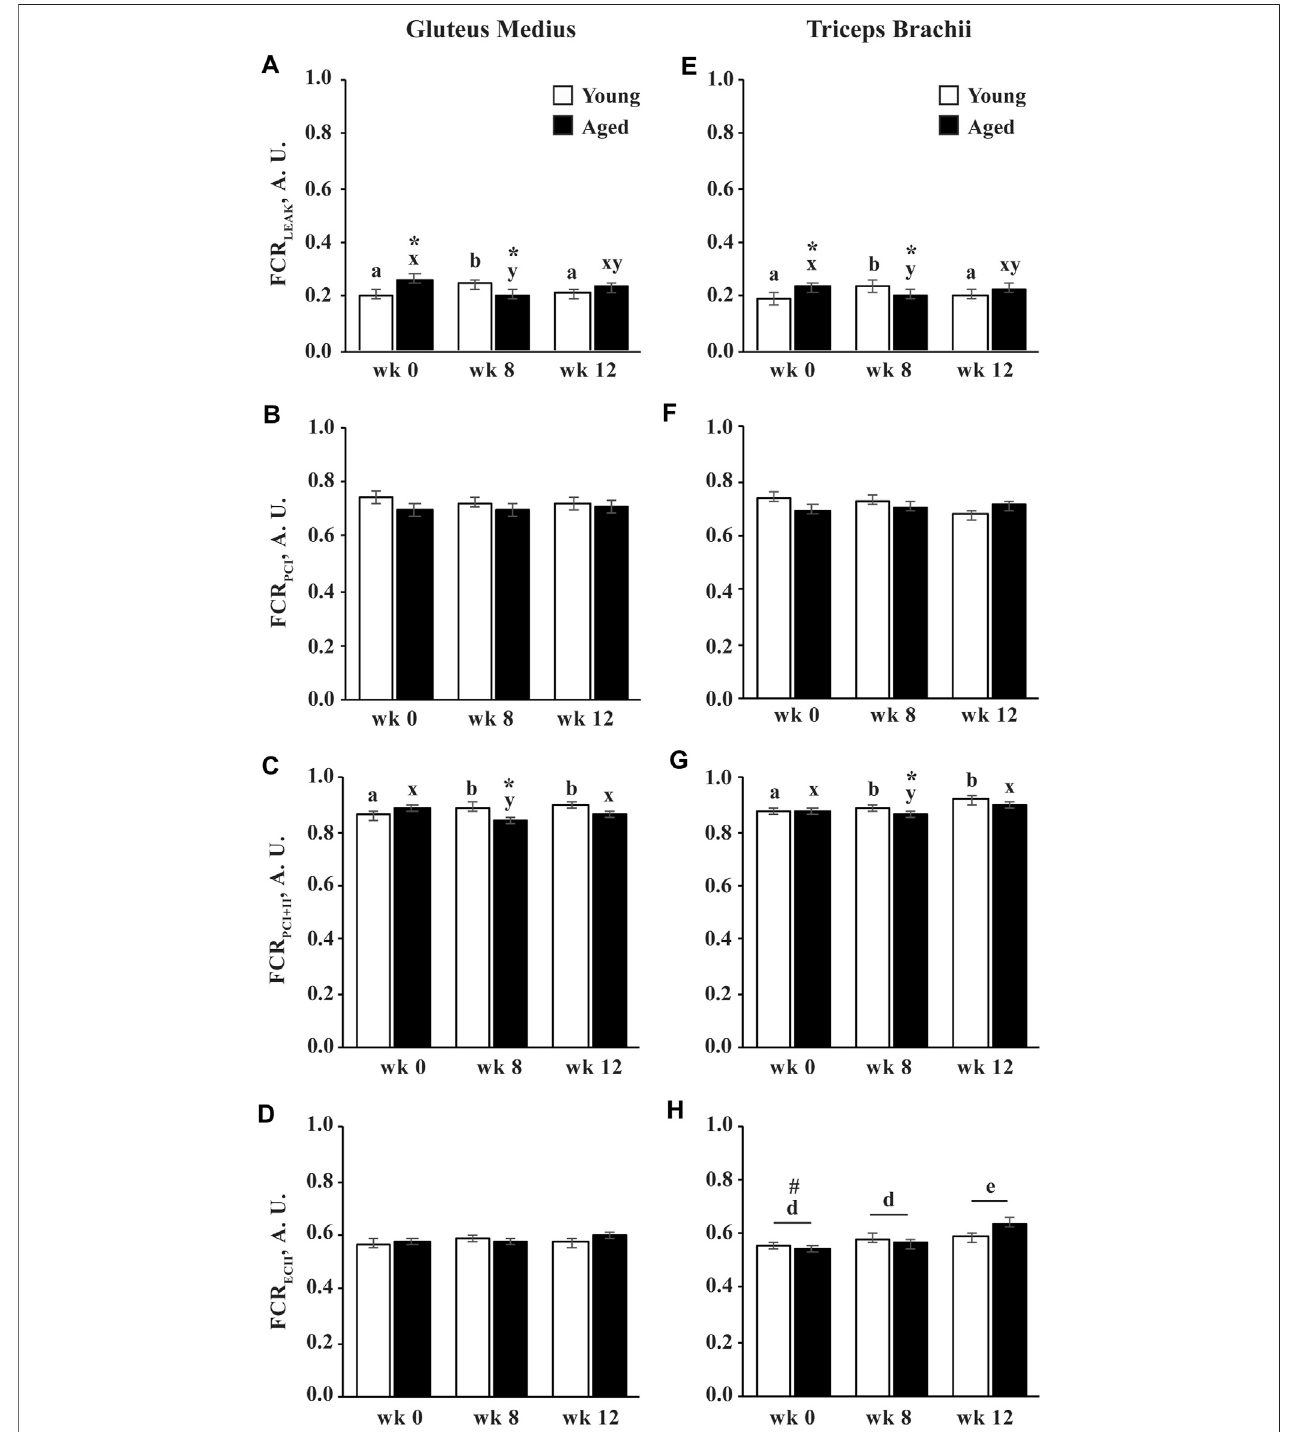
FIGURE 7 | Flux control ratio (FCR) of permeabilized fi bers from the gluteus medius and triceps brachii before (wk 0), and after 8 (wk 8) and 12 (wk 12) weeks of submaximalexercisetraininginaged(22 ± 4.5yr; n (cid:1) 10)andyoung(9.7 ± 0.7mo; n (cid:1) 8)horses.ContributionofLEAKrespiration(LEAK; A , E ),complexI-supportedoxidative phosphorylationcapacity(P CI ; B , F ),complexIandII-supportedP(P CI+II ; C , G ),andcomplexII-supportedelectrontransfercapacity(E CII ; D , H )tomaximalnoncoupledE(E CI+II ). Overalleffectofage( p (cid:1) 0.15; p (cid:1) 0.05; p (cid:1) 0.05; p (cid:1) 0.04; p (cid:1) 0.04),training( p (cid:1) 0.0005; p (cid:1) 0.056; p (cid:1) 0.12; p (cid:1) 0.10; p (cid:1) 0.12),musclegroup( p (cid:1) 0.2; p (cid:1) 0.5; p (cid:1) 0.5; p (cid:1) 0.3; p (cid:1) 0.3),age × training( p (cid:1) 0.06; p (cid:1) 0.11; p (cid:1) 0.2; p (cid:1) 0.14; p (cid:1) 0.2),age × musclegroup( p (cid:1) 0.7; p (cid:1) 0.9; p (cid:1) 0.99; p (cid:1) 0.9; p (cid:1) 0.8),training × musclegroup( p (cid:1) 0.3; p (cid:1) 0.6; p (cid:1) 0.5; p (cid:1) 0.5; p (cid:1) 0.4),andage × training × musclegroup( p (cid:1) 0.8; p (cid:1) 0.9; p (cid:1) 0.9; p (cid:1) 0.9; p (cid:1) 0.97)forFCR LEAK ,FCR PCI ,FCR PCI+II ,andFCR ECII ,respectively. * Within week, aged differs from young ( p < 0.05). # Within week, GM differs from TB ( p < 0.05). a,b Within young horses, time points with different letters differ ( p < 0.05). x,y Within aged horses, time points with different letters differ ( p < 0.05). d,e Within muscle group, time points with different letters differ ( p < 0.05).